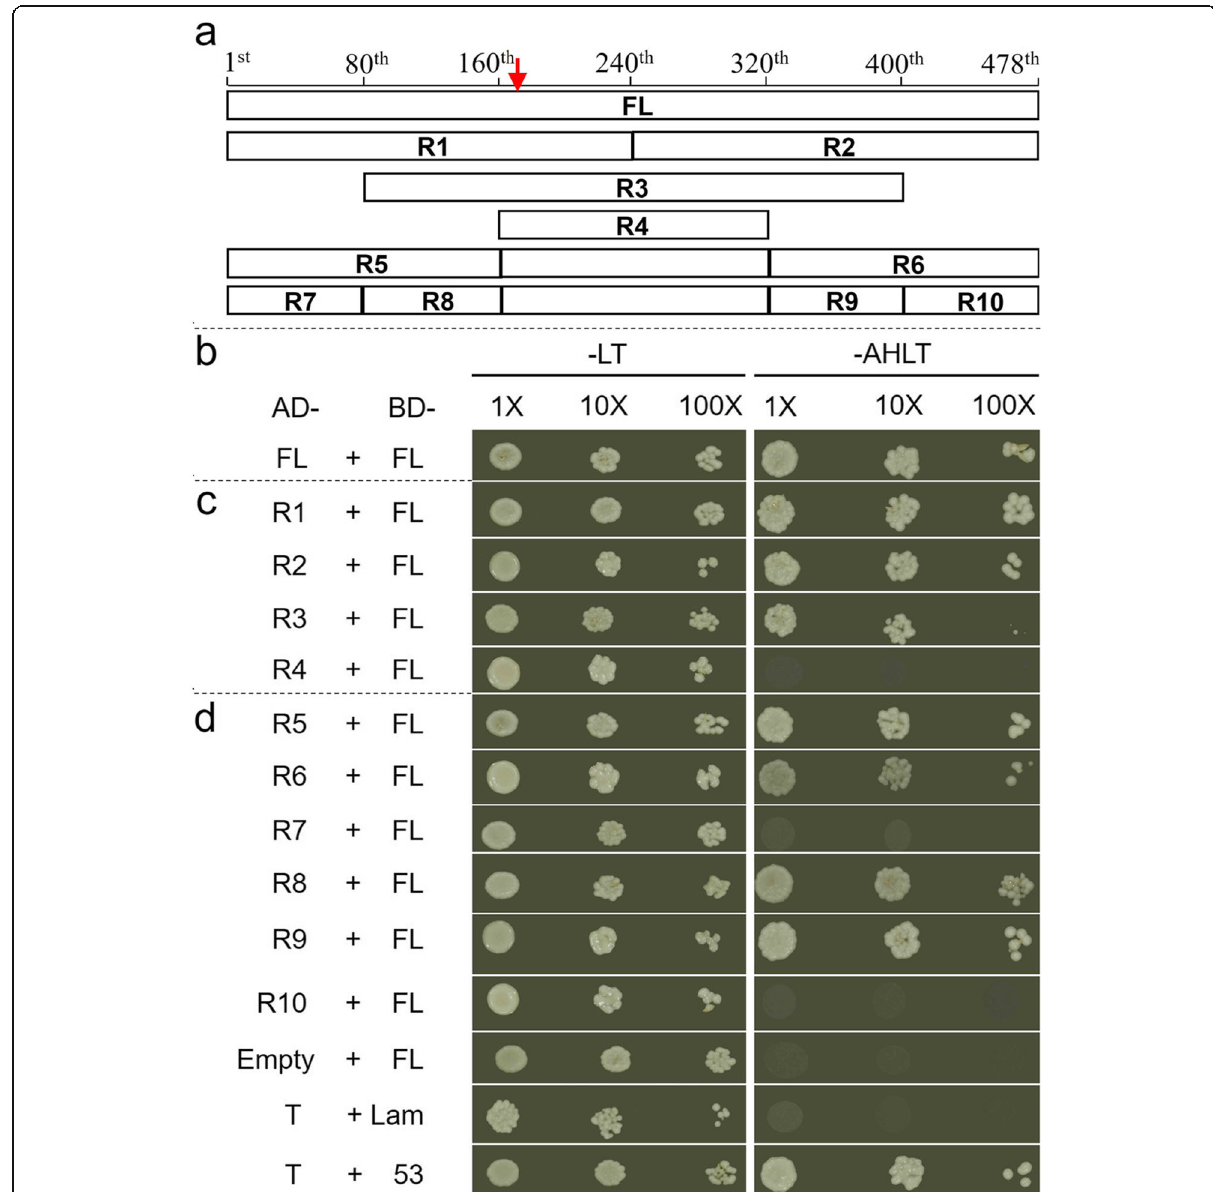
Fig. 8 OsGSAM protein truncation experiment. a Schematic diagram of OsGSAM protein truncation. FL represents the full-length OsGSAM, and R1-R10 correspond to truncated fragments containing the 1st-240th, 241th – 478th, 81th – 400th, 161th – 320th, 1st-160th, 321th – 478th, 1st-80th, 81th – 160th, 321th – 400th and 401th – 478th amino acid residues of OsGSAM, respectively. The red arrow indicates the substitution of threonine for alanine at the 171th amino acid residue of OsGSAM in the ys53 mutant. b The yeast two-hybrid experiment of the full-length OsGSAM with itself. c Yeast two-hybrid experiments between the R1, R2, R3 and R4 fragments and the full-length GSAM. d Yeast two-hybrid experiments between the R5, R6, R7, R8, R9 and R10 fragments and the full-length GSAM. The FL was combined with empty pGADT7 vector as internal control. Interaction between pGADT7-T and pGBKT7-Lam was used as a negative control, and interaction between pGADT7-T and pGBKT7 – 53 was used as a positive control. Co-transformed yeast colonies were spotted on the selective SD medium minus Trp and Leu ( − LT), the normally surviving monoclonal bacteria were selected and then dripped to the SD medium minus His, Leu, Trp and Ade to grow ( − AHLT). 1X, 10X, and 100X represent the saturated culture solution of transformant diluted to concentrations of 1, 0.1 and 0.01,